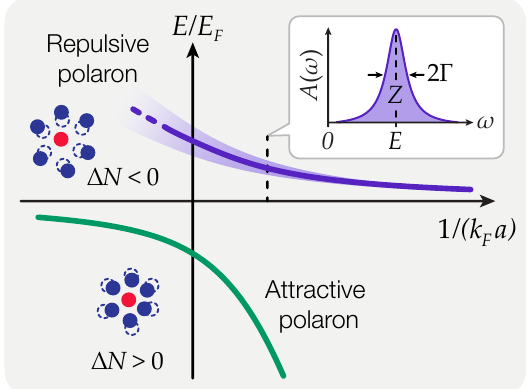
Figure 1. Quasiparticle spectrum as a function of interaction strength 1/ ( k F a ) . Attractive (green) and repulsive (purple) polaron energy branches. The shaded area centered around the repulsive polaron energy represents the quasiparticle spectral width Γ . For widths comparable to its energy, the repulsive polaron ceases to be a well defined coherent quasiparticle (dashed line ending). In the case of a fermionic medium, the attractive polaron also stops being well defined at sufficiently large 1/ ( k F a ) , where it undergoes a sharp transition to a dressed molecule quasiparticle [59]. On the other hand, the ground state of the Bose polaron spectrum does not feature a single-impurity transition. Inset: impurity spectral function A ( ω ) at zero momentum for ω > 0, i.e., a vertical cut through the repulsive polaron spectrum at fixed interaction strength. The center of the polaron spectral function denotes the polaron energy E , while its half width at half maximum and area relate to the quasiparticle width Γ and residue Z ,